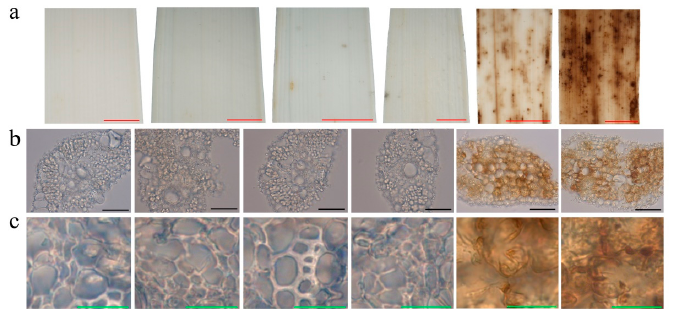
Figure 4. Diaminobenzidine (DAB) staining on the leaves of ZJ22 and pir1 sampled at the five-leaf stage. Each set of images represents (from left to right), the flag, 2nd and 3rd leaves of ZJ22, and then the flag, 2nd and 3rd leaves of pir1 . ( a ) Leaf phenotype; red scale bar = 0.2 cm. ( b ) Cell morphology; black scale bar = 50 μ m. ( c ) Magnified cell morphology; green scale bar = 10 μ m.